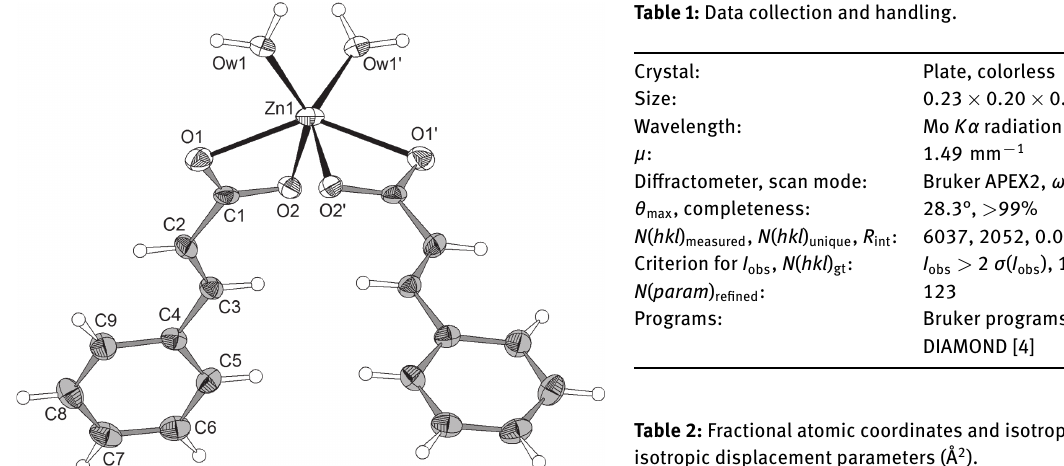
Table 1: Data collection and handling.